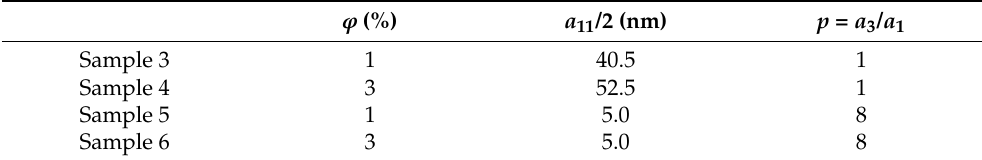
Table 4. Data from